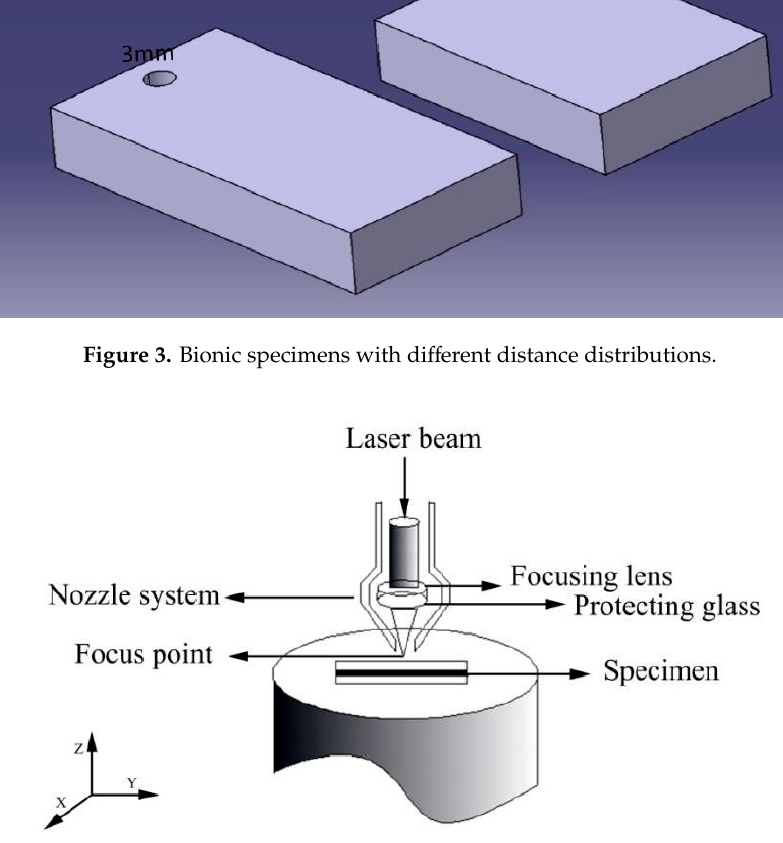
Figure 4. Schematic diagram of laser processing process. Table 2. Laser parameters.